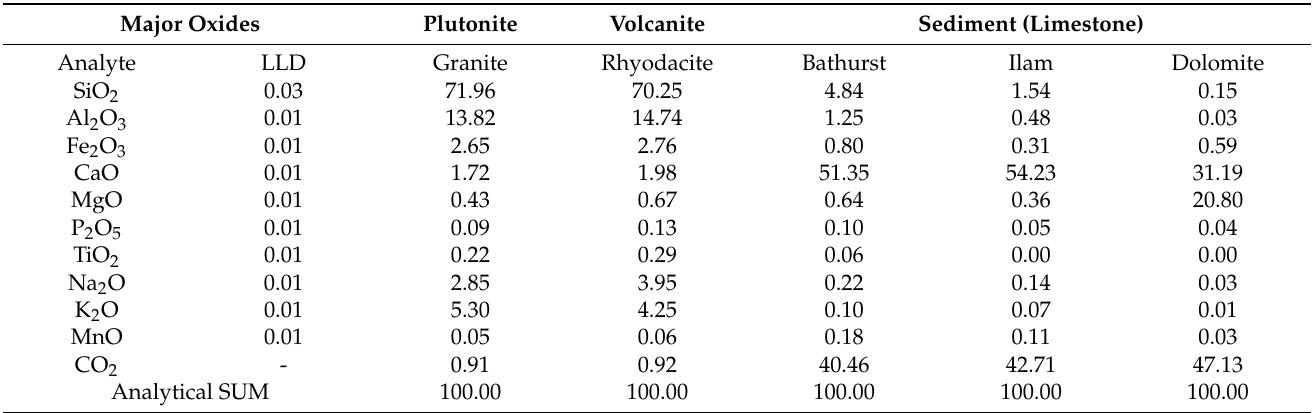
Table 2. X-ray fluorescence analysis of the